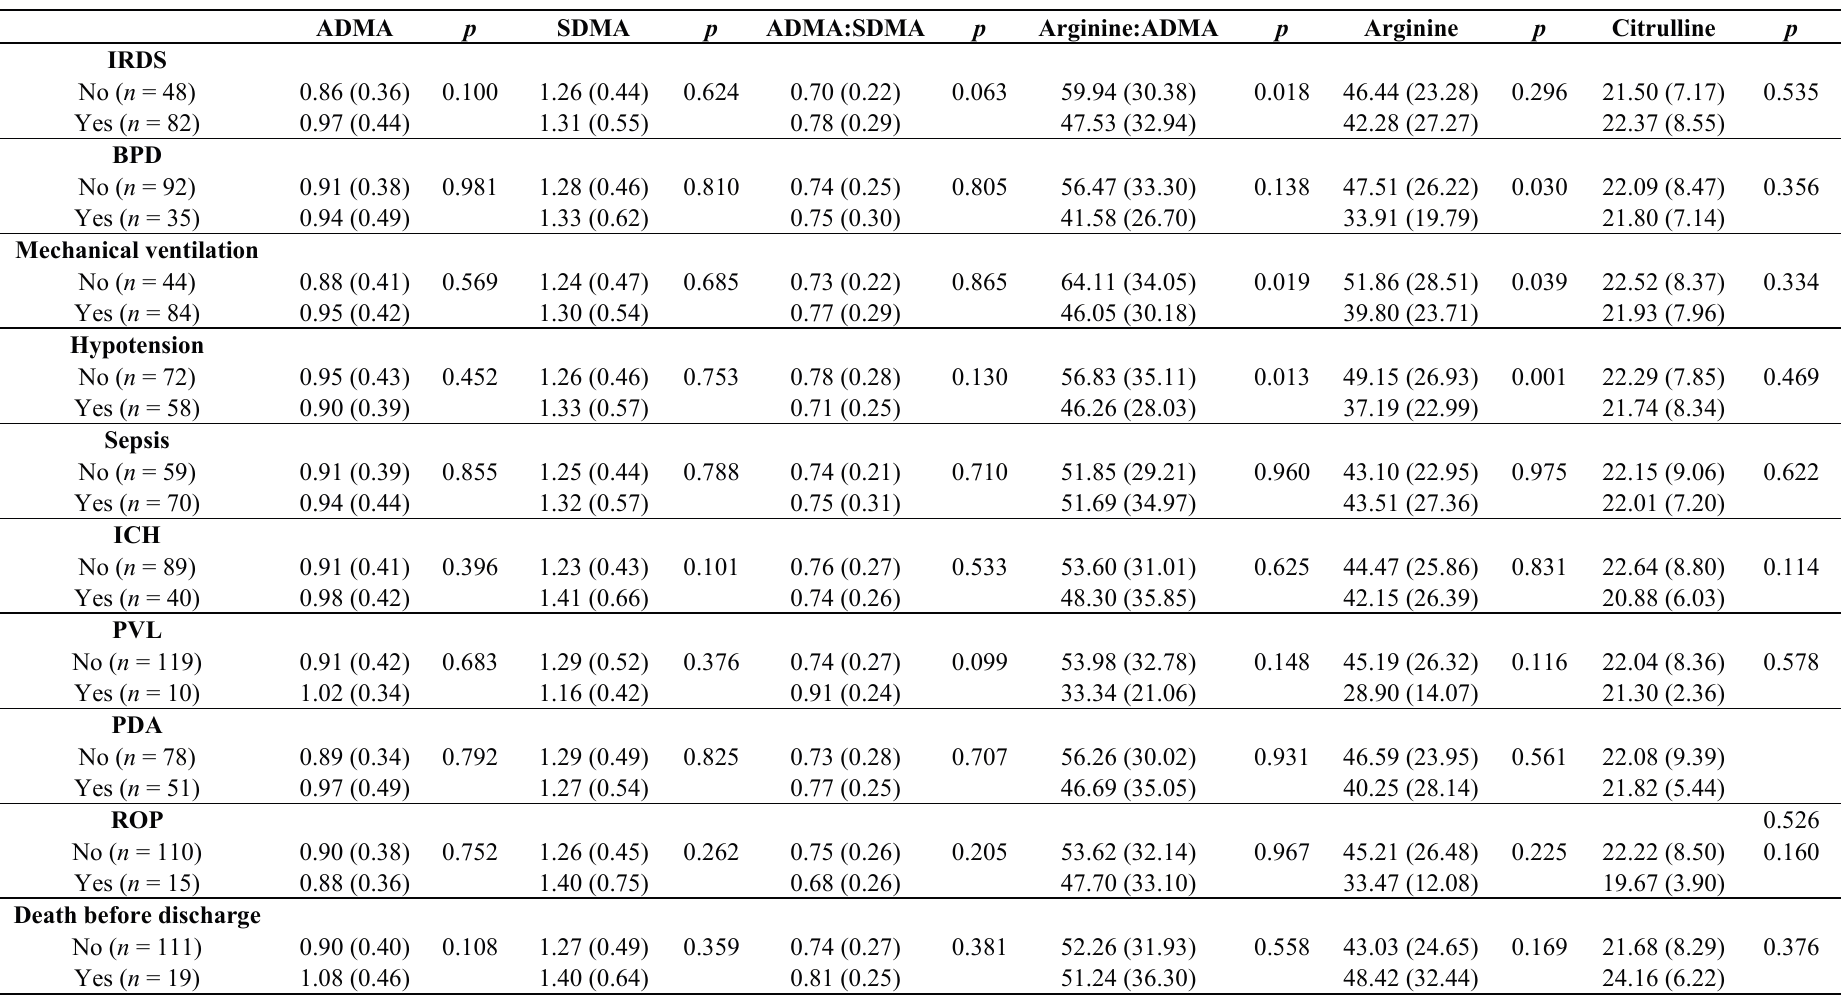
Table 5. Effects of several neonatal outcomes on dimethylarginines, arginine, citrulline levels and ratios in in very low birth weight